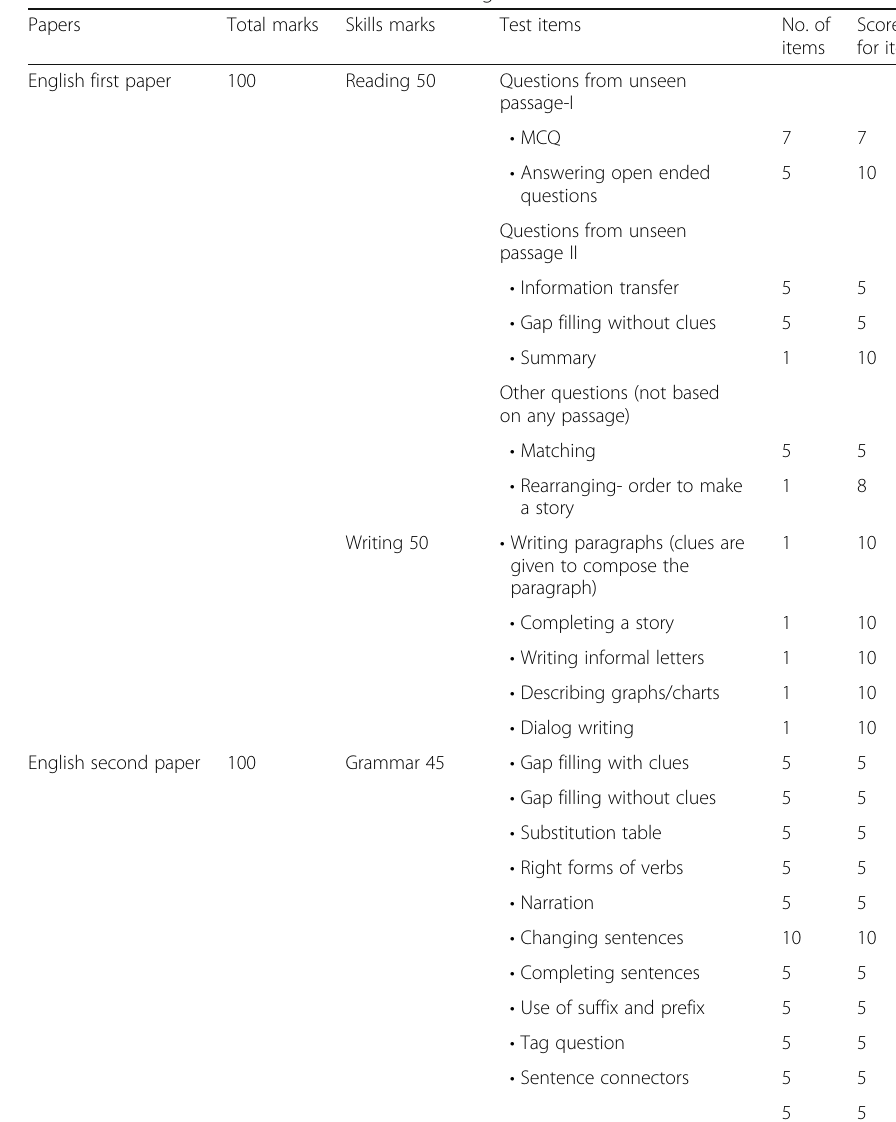
Table 1 Mark distribution and structure of SSC English examination